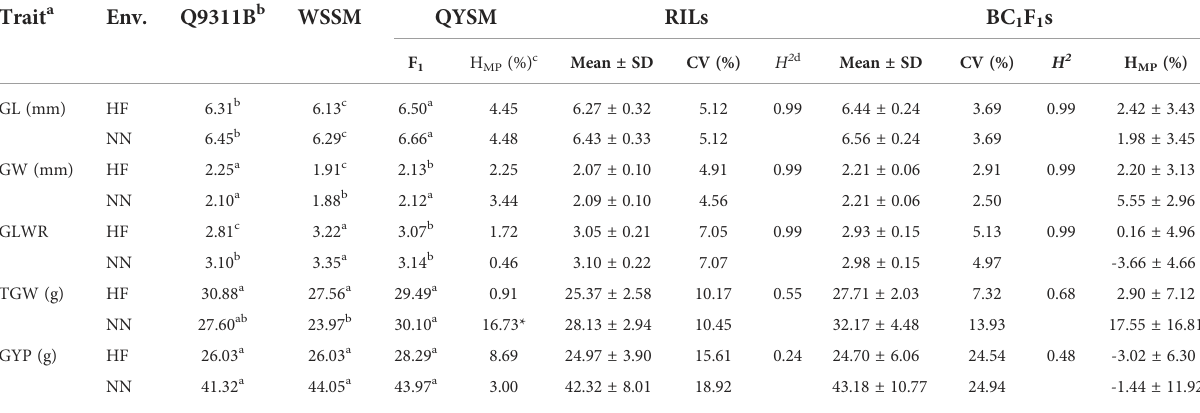
TABLE 1 Phenotypic performance and broad-sense heritability of grain shape and grain weight as well as grain yield traits in the parent lines, QYSM (Q9311A × WSSM), RILs, BC 1 F 1 s (Q9311A × RILs), and their H MP s in Hefei (HF) and Nanning (NN). Trait a